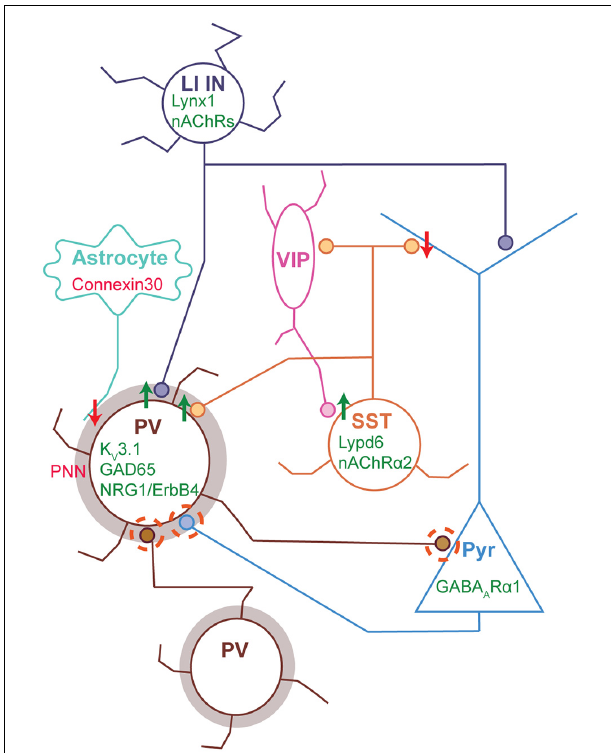
FIGURE 3 | Molecular and synaptic loci of plasticity during sensory critical periods. Cortical circuit schematic with major synaptic connections and molecular factors regulating critical period plasticity. The circuit depicted shows the circuit motifs and cellular components regulating CP plasticity: basket PV INs (Brown) inhibit one another and exert strong inhibitory control of Pyr (light blue) through perisomatic inhibition; layer I INs (dark blue) inhibit the apical dendrites of Pyr and can also target PV cells, resulting in simultaneous Pyr somatic disinhibition and dendritic inhibition; Martinoti SST INs (yellow) across layers target Pyr apical dendrites and also receive input from VIP INs (pink), such that VIP activation results in Pyr disinhibition; while a subset layer IV SST INs target PV INs preferentially, resulting in disinhibition; and astrocytes regulate the extracellular matrix and PNN formation onto PV INs. PV IN maturation determines both the onset and closure of cortical critical periods. Maturation of PV intrinsic properties, synaptic inputs (both excitatory and inhibitory, dashed circles), and inhibitory synaptic output onto Pyr (dashed circle) are all crucial for CP plasticity. Expression of K V 3.1, GAD65 and NRG1/ErbB4 in PV INs promote (green) normal CP plasticity (Hensch et al., 1998; Matsuda et al., 2021; Zheng et al., 2021), while PNN (brown shadow) maturation in PV INs prevent and close CP plasticity (Pizzorusso et al., 2002; Nowicka et al., 2009; Sigal et al., 2019). In addition, GABA A α 1 receptor expression in Pyr (in putative PV synapses) is necessary for CP plasticity (Fagiolini et al., 2004). Both SST and LI INs can induce CP plasticity indirectly by means of PV IN inhibition, such that the expression of molecular factors promoting SST (Lypd6 and nAChR α 2) or LI IN (Lynx1 and nAChRs) activity enhance plasticity (Takesian et al., 2018; Sadahiro et al., 2020). On the other hand, VIP IN-mediated Pyr disinhibition, via SST inhibition, also promotes cortical plasticity (Fu et al., 2015). In contrast, connexin 30 expression in astrocytes restricts CP plasticity via PNN maturation in PV INs (Ribot et al., 2021). Green font/arrows represent molecules or synapses promoting CP plasticity, while red font/arrows represent those preventing plasticity. Abbreviations: PV, Parvalbumin; Pyr, Pyramidal cell; SST, Somatostatin; LI INs, Layer I interneurons; VIP, Vasoactive intestinal peptide; PNN, Perineuronal net; nAChRs, Nicotinic Acetylcholine receptors; NRG1, Neuregulin 1; K V 3.1, Potassium channel 3.1; GAD65, Glutamic acid decarboxylase